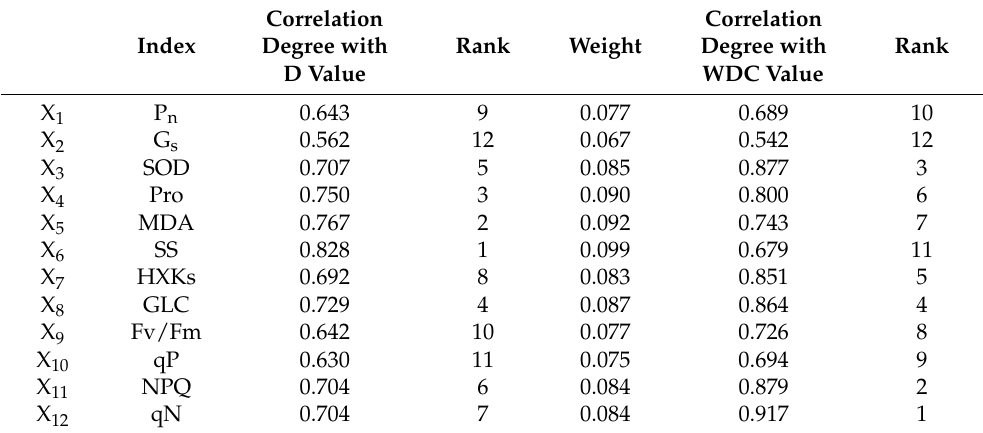
Table 4. Correlation degree between the DC value of all the indices and the D value, together with the WDC value and the weights of their indices.